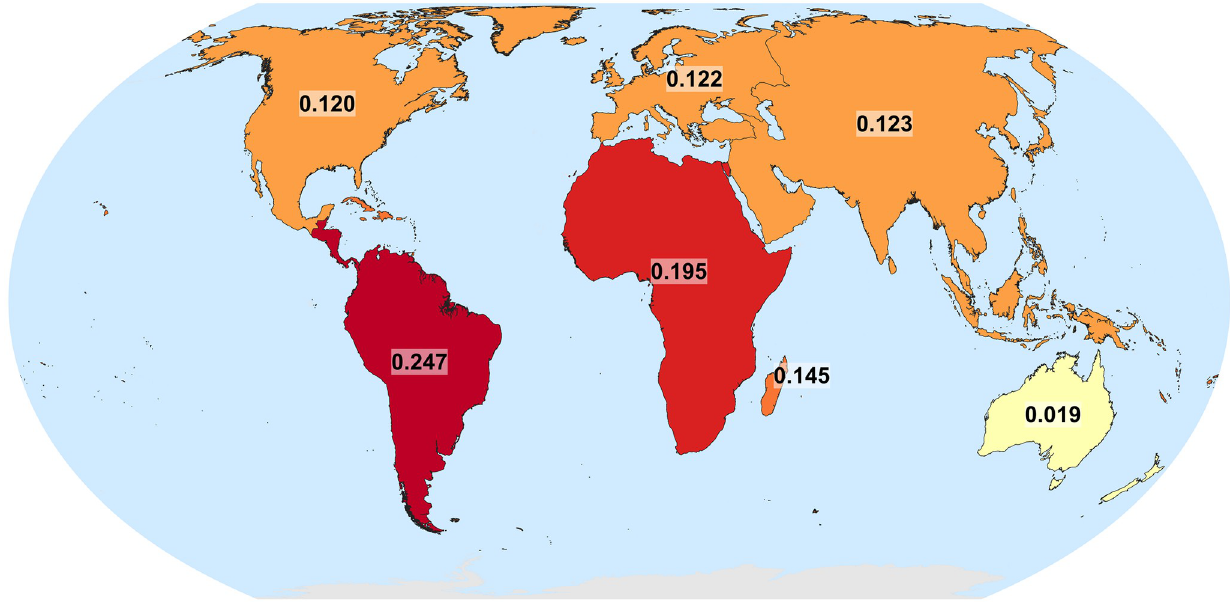
Fig 4. Ratio of 2019 mountain-only population count to total population count by IPCC regions according to the K1 mountain delineation and LandScan population. The 0.145 value corresponds to all “Small Island” regions globally.